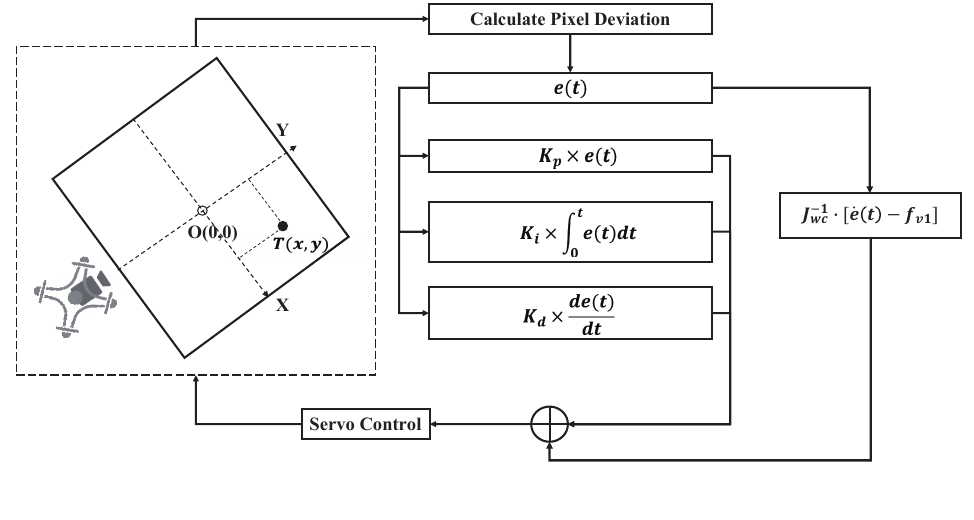
Figure 8. PTZ control system schematic